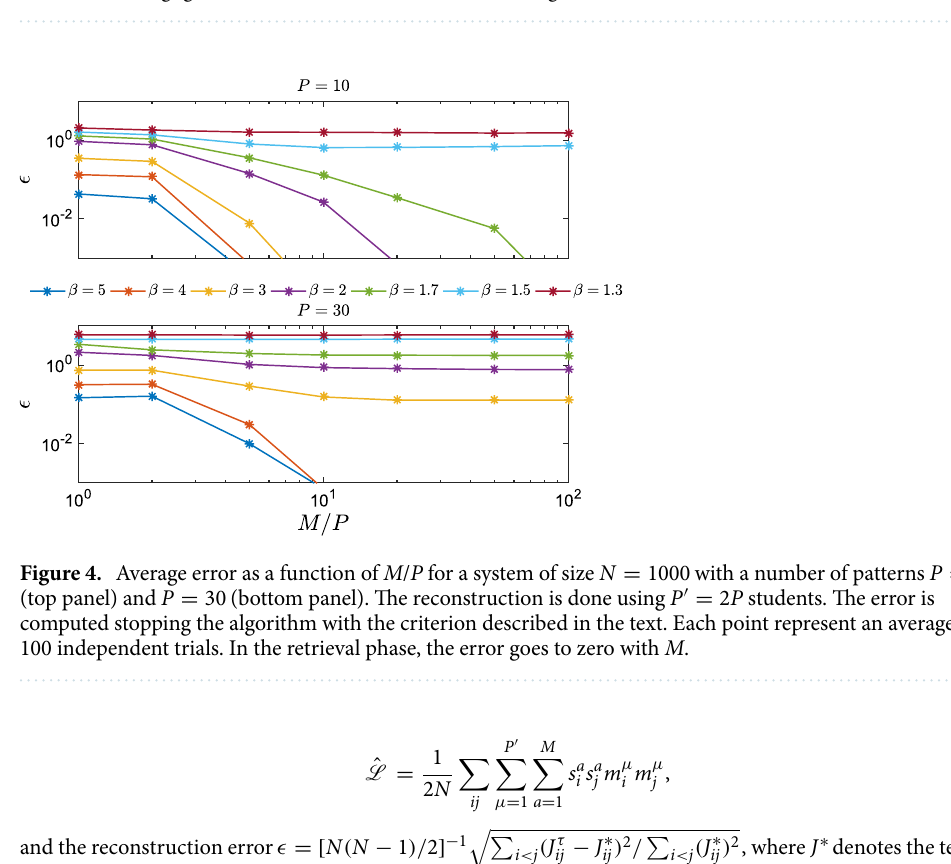
Figure 3. Evolution of the error ǫ and of the simplified Likelihood ˆ L , as defined in the text, with the iteration of the algorithm. Different lines refer to different values of M The error decreases with M and it reaches zero for M samples, the errors are very small and, as shown on Fig. 2 the patterns are perfectly recovered. The dependency of ˆ L on M is negligible. ˆ L is rescaled in order to fit in the figure.